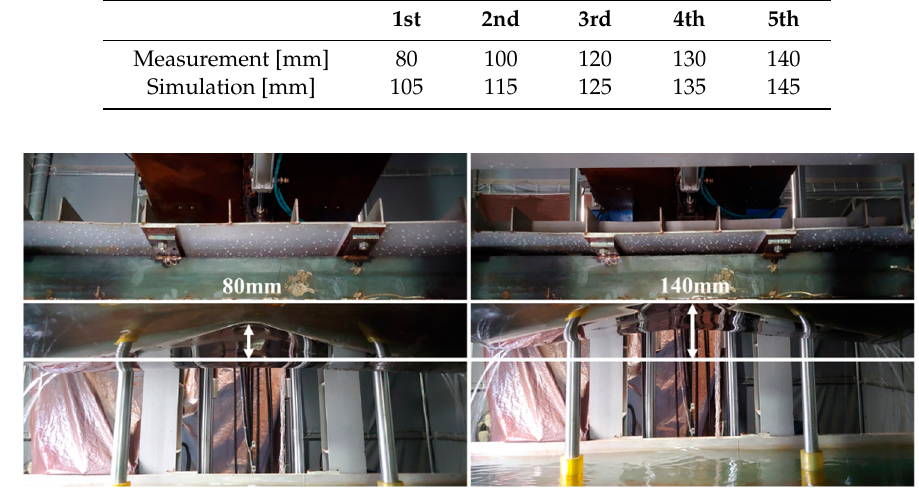
Figure 19. Measurement of the 1st free drop test (left) and the 5th free drop test (right).